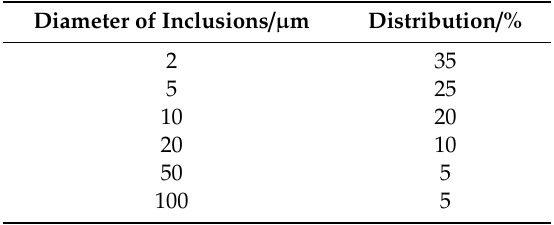
Table 4. Diameters of simulated inclusions and their distribution in the total volume of inclusions.